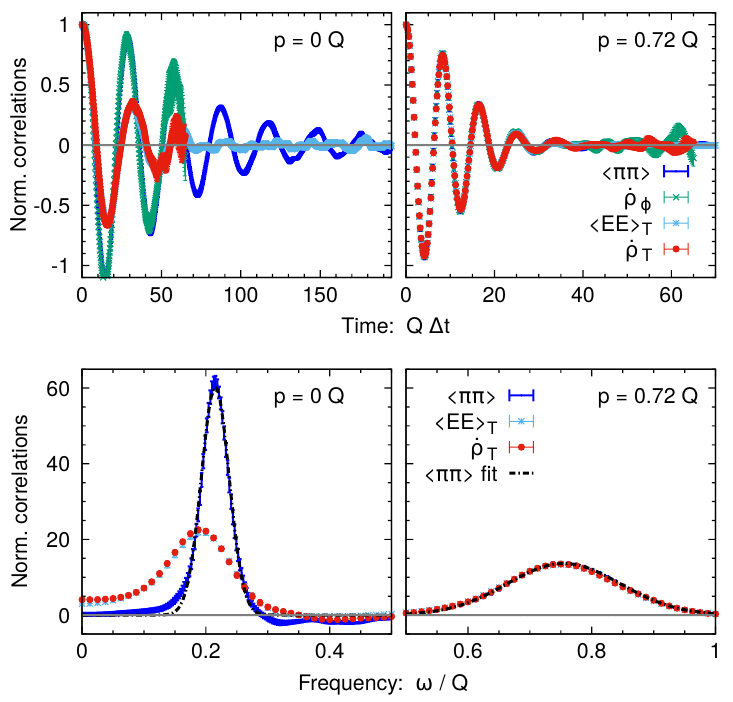
Figure 6 . Different scalar and transverse correlators of the Glasma-like 2+1D theory for mo- menta p = 0 Q (left) and p = 0 . 72 Q (right). The scalar correlations are seen to also satisfy the generalized fluctuations-dissipation relation and even to agree with transverse correlations at high momenta, while differing at low momenta. Top: the correlation functions h ππ i / h ππ i (∆ t =0 , p ) , ˙ ρ h EE i T / h EE i T (∆ t =0 , p ) and ˙ ρ T as functions of time ∆ t . Note that in the left panel the range of ∆ t is longer. Bottom: the same correlators as in the top row but now in the frequency domain ω . The scalar dotted spectral function ˙ ρ φ is not shown because Q ∆ t max of at least 200 would be necessary while the correlator becomes very noisy for & 80 . Gaussian fits to the scalar correlator h ππ i are shown as black dashed lines.